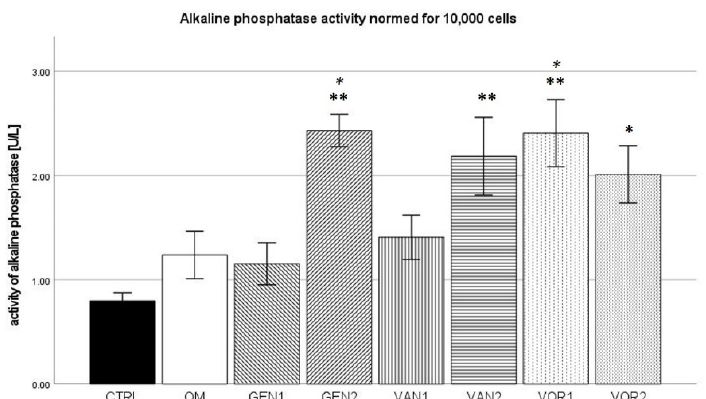
Figure 8. Mean AP activity per group as measured in the cell culture medium. The error bars show the error of mean.